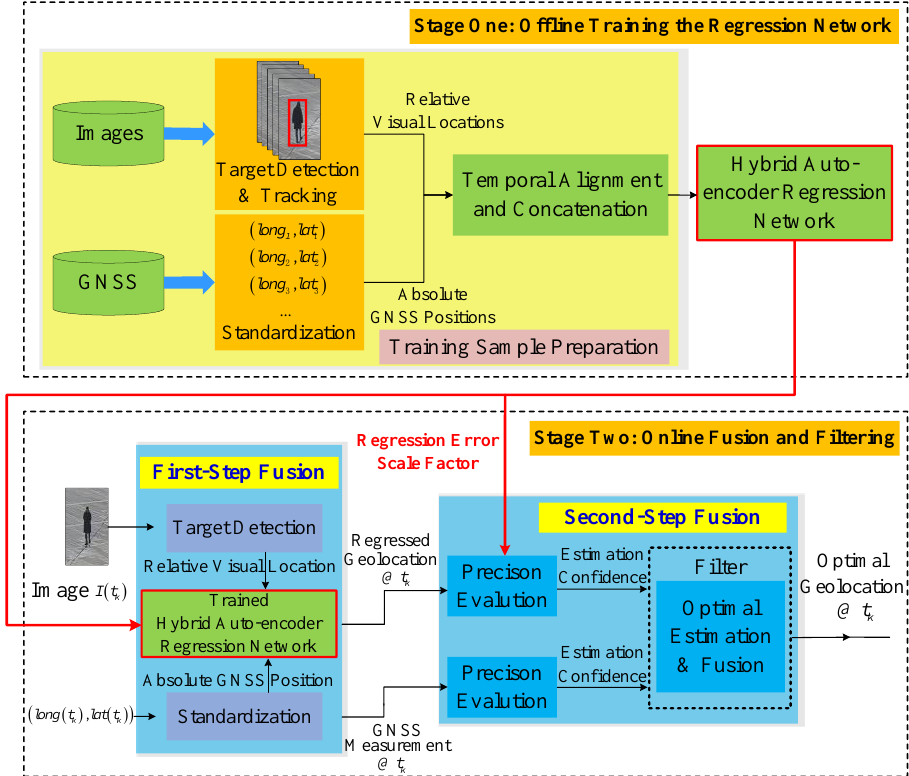
Figure 2. Overview of the proposal.